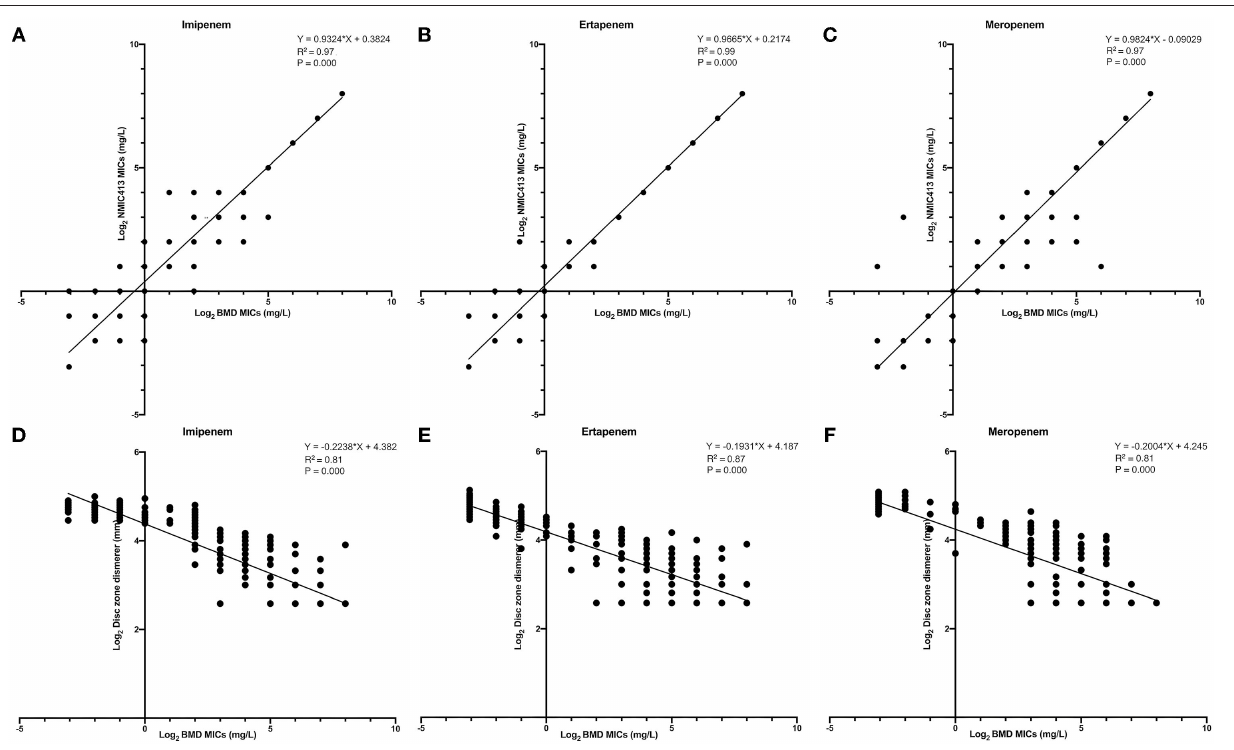
FIGURE 4 | The linear regression curve between the MICs determined by BD NMIC-413, disk diffusion and broth microdilution. (A) (imipenem), (B) (ertpenem), and (C) (meropenem) were curves between BD NMIC-413 and broth microdilution; (D) (imipenem), (E) (ertpenem), and (F) (meropenem) were curves between disk diffusion and broth